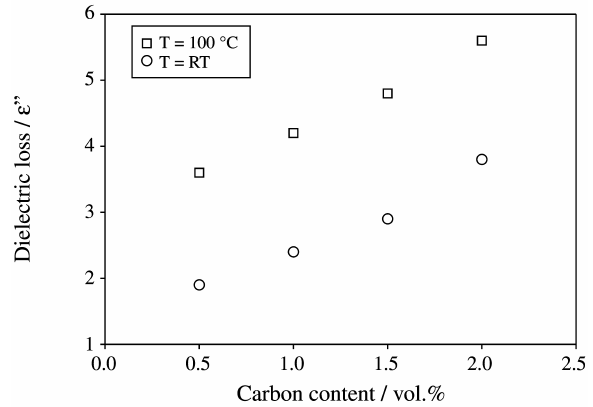
Figure 6. Variation of dielectric loss with the semiconductor phase content in the composite. Frequency = 1kHz.( )T = 100 °C,(O) T = RT.